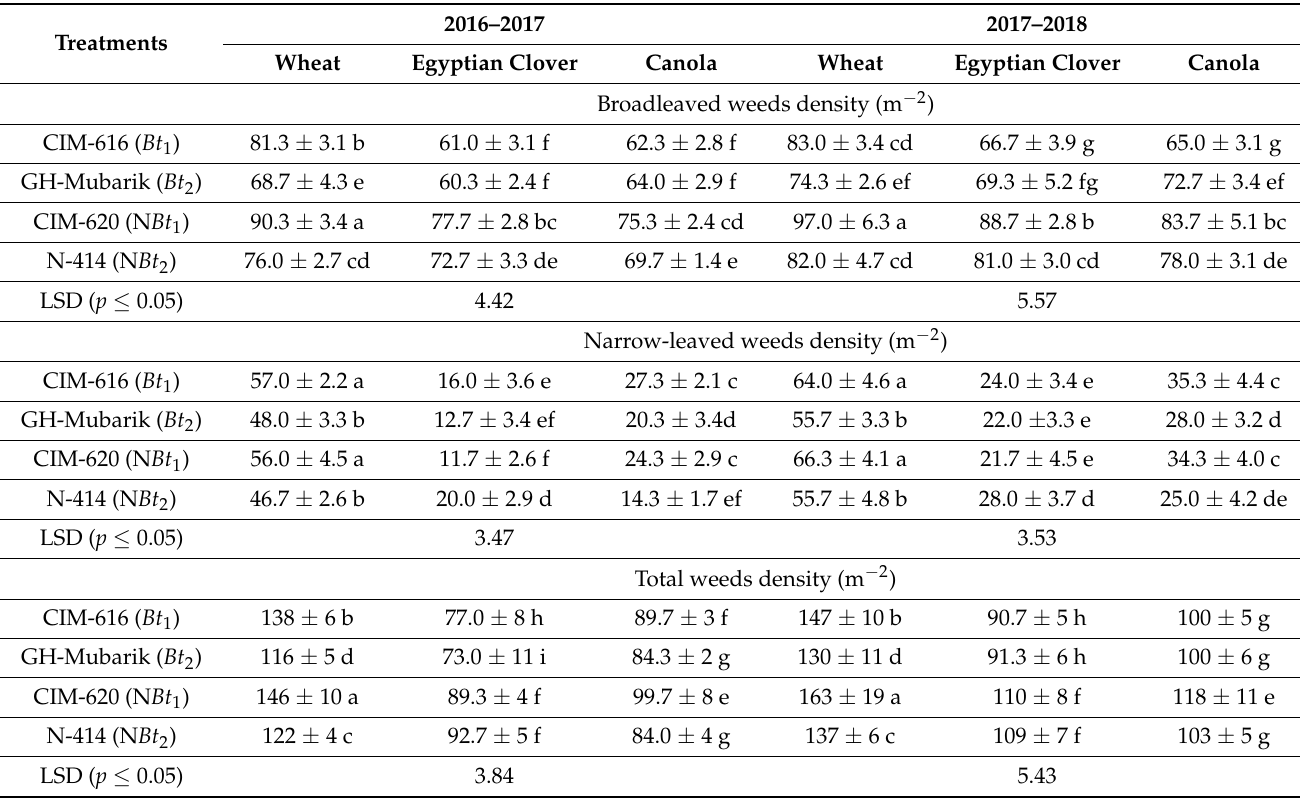
Table 4. Interactive effects of different cotton genotypes and winter crops on the densities of broadleaved, narrow-leaved, and total weeds recorded in winter